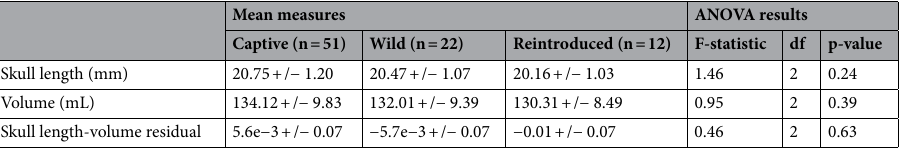
Table 1. Mean measures of skull length, endocranial volume, and the residual of the regression of skull length and endocranial volume (+ /- standard deviation) as well as the ANOVA results associated with each. P -value